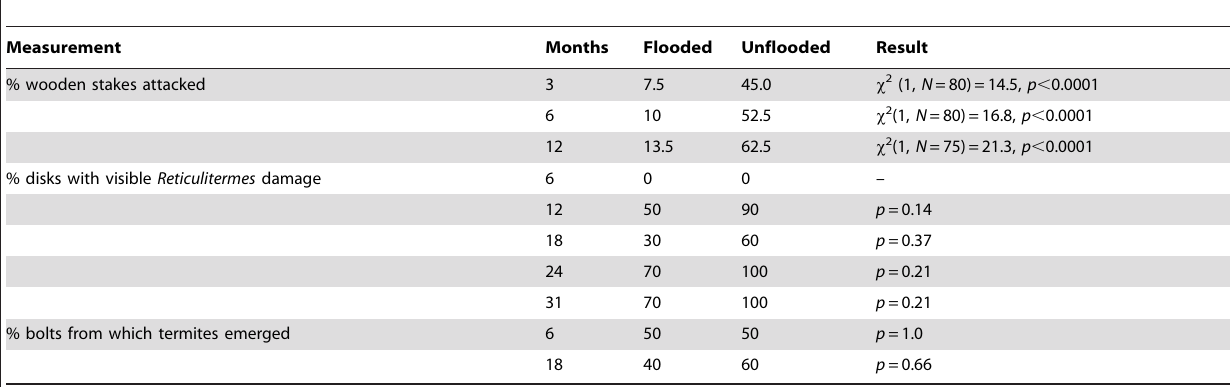
Table 3. Comparisons of Reticulitermes activity in wooden stakes and unprotected bolts between flooded and unflooded forests.